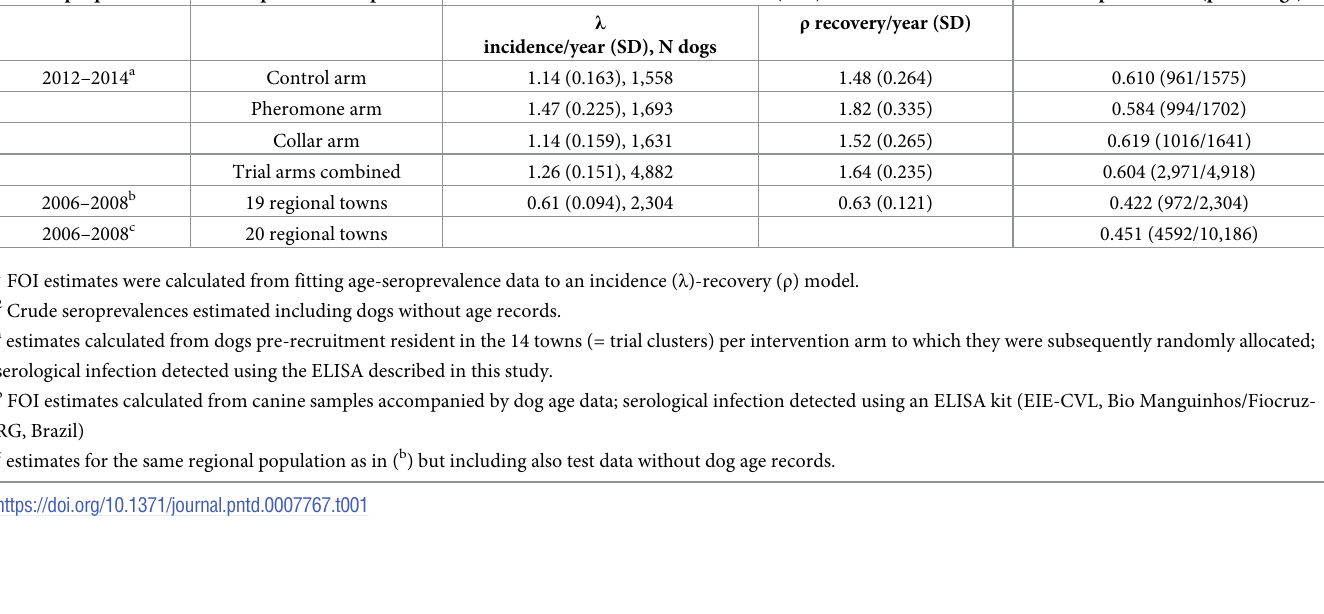
Table 1. Serological infection estimates calculated for dogs surveyed prior to trial recruitment, and from canine historical testing records in the same region. Sample